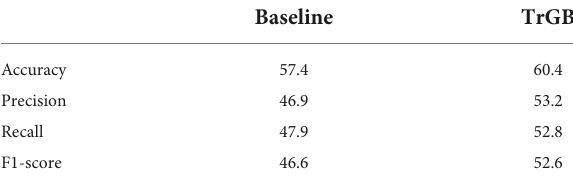
TABLE 5 CN/AD classification scores for the baselines, source-model, TrAdaBoost, and TrGB (proposed) scenarios using the multimodal data.